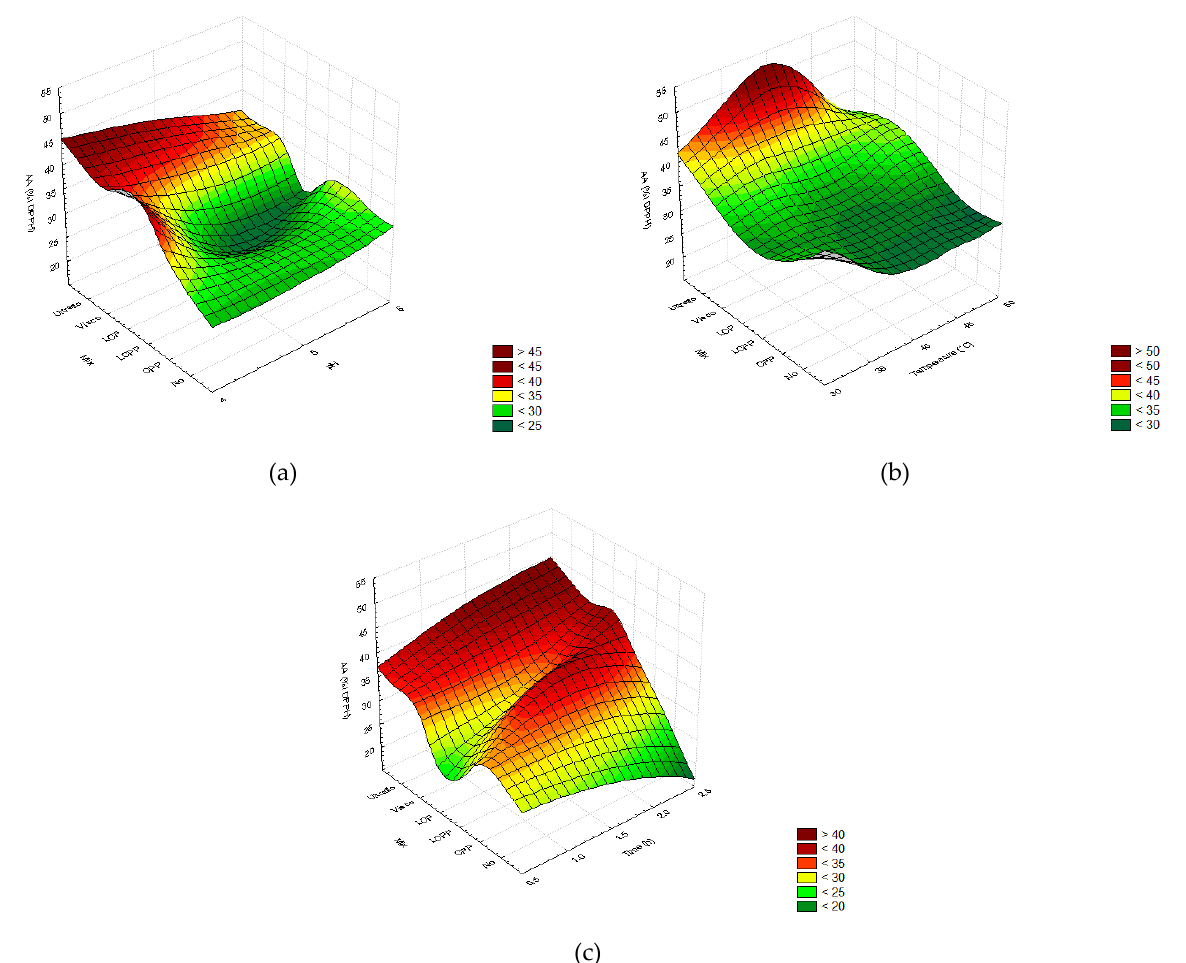
Figure 8. The DPPH-radical scavenging capacity (AA, %I DPPH) in ethanolic extracts plotted as a function of the different enzymatic cocktails. ( a ) pH (4 – 6), ( b ) temperature (30 – 50 °C), and ( c ) time (0.5 – 2.5 h). In order, two commercial cocktails: Ultraflo© (Ultraflo) and Viscozyme© (Visco); three formulated cocktails with laccase, cellulase, and pectinase at proportions of 1:1:1 (LCP), 1:1:2 (LCPP), and 0:1:2 (CPP); and the control without added enzymes (No). The color scale indicates the significance of the analysis of variance for the Taguchi method ( p > 0.05).